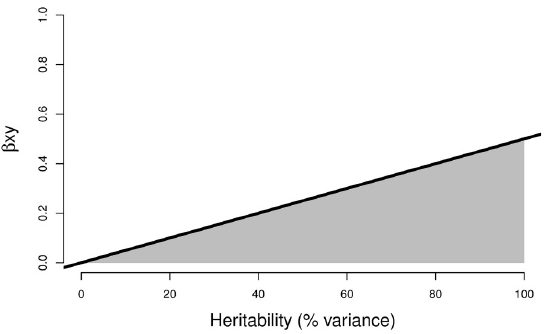
Fig 6. The role of genetics in explaining phenotypic associations between parent and child. Standardized observed associations between the same traits in the mother (or father) and the child are represented as a function of trait heritability. An observed association of 0.20 with trait heritability of 0.60 is consistent with complete genetic confounding. Conversely, an association of 0.40 with heritability of 0.40 is not consistent with complete genetic